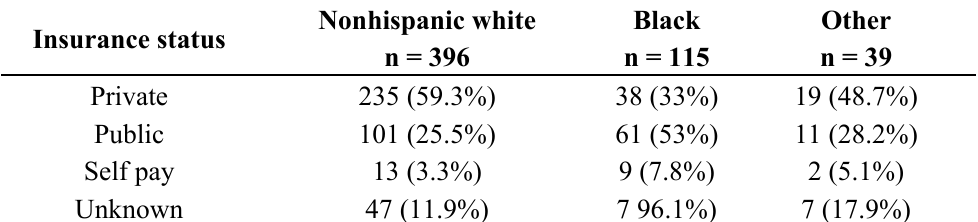
Table S4. Insurance status by